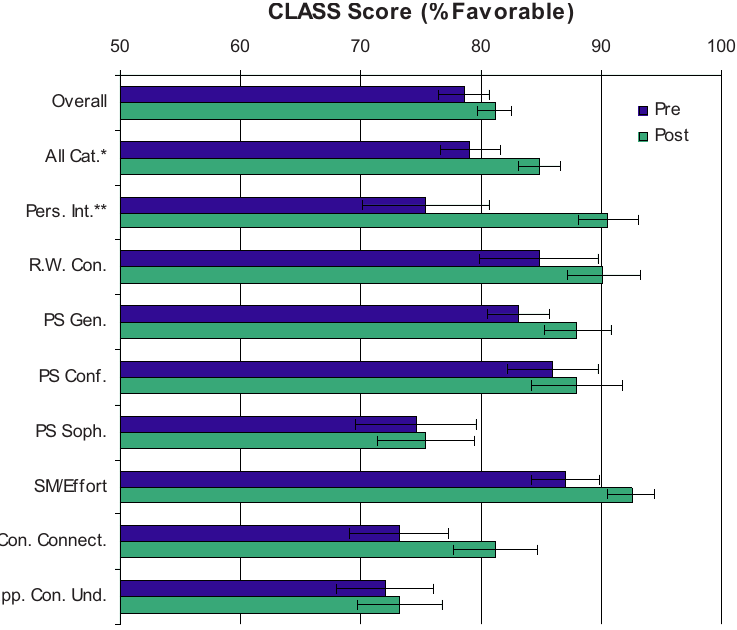
FIG. 2. (cid:1) Color online (cid:2) Average CLASS results from Spring 2008 (cid:1) N =23 (cid:2) . Error bars reflect the Standard Error of the Mean. (cid:1) p (cid:1) 0.05, (cid:1)(cid:1) p